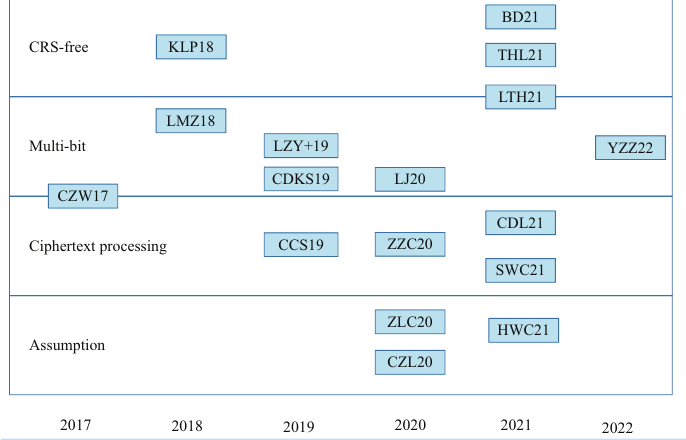
Figure 2. MKFHE developments by improvement steps.